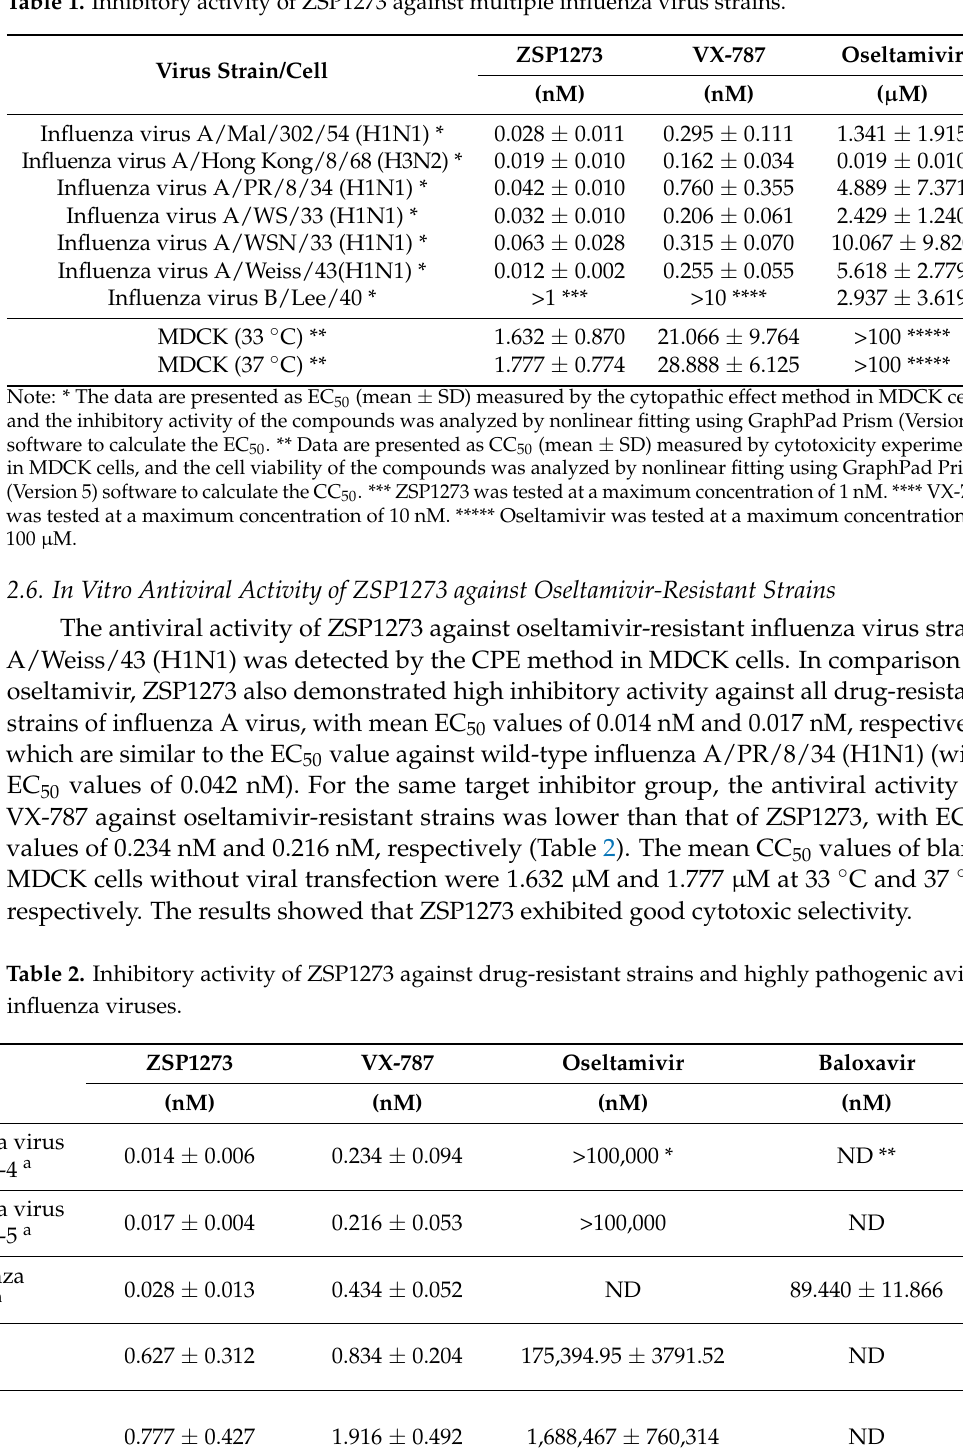
Table 1. Inhibitory activity of ZSP1273 against multiple influenza virus strains.